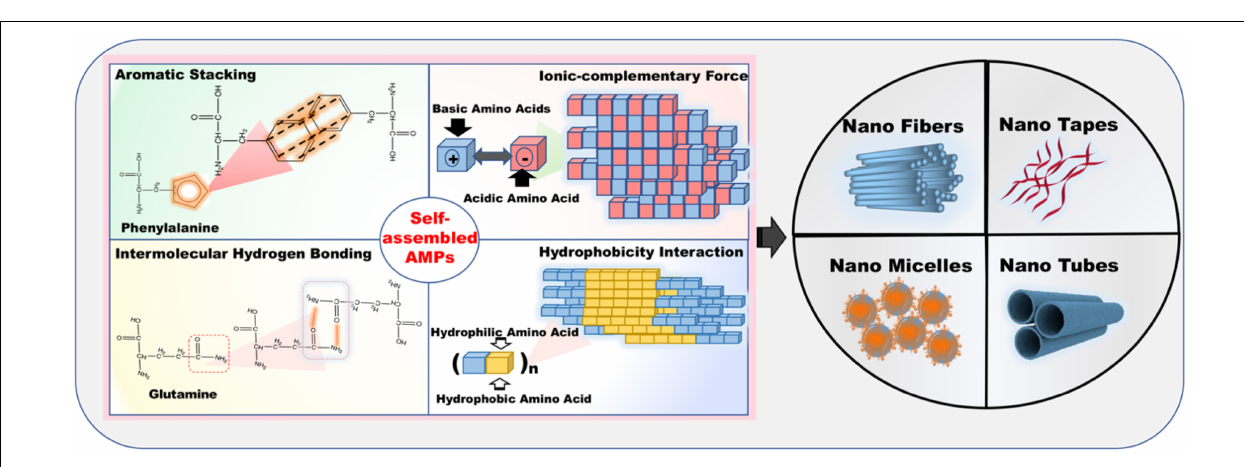
FIGURE 12 | The typical antimicrobial mechanisms of most organic material nanosystems containing AMPs.